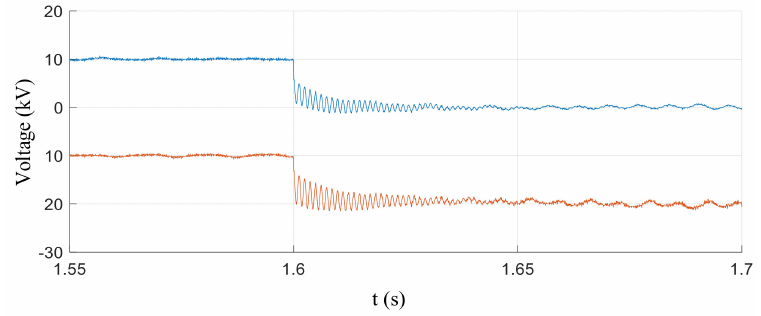
Figure 15. Voltage waveform of the DC-side single-pole to ground.